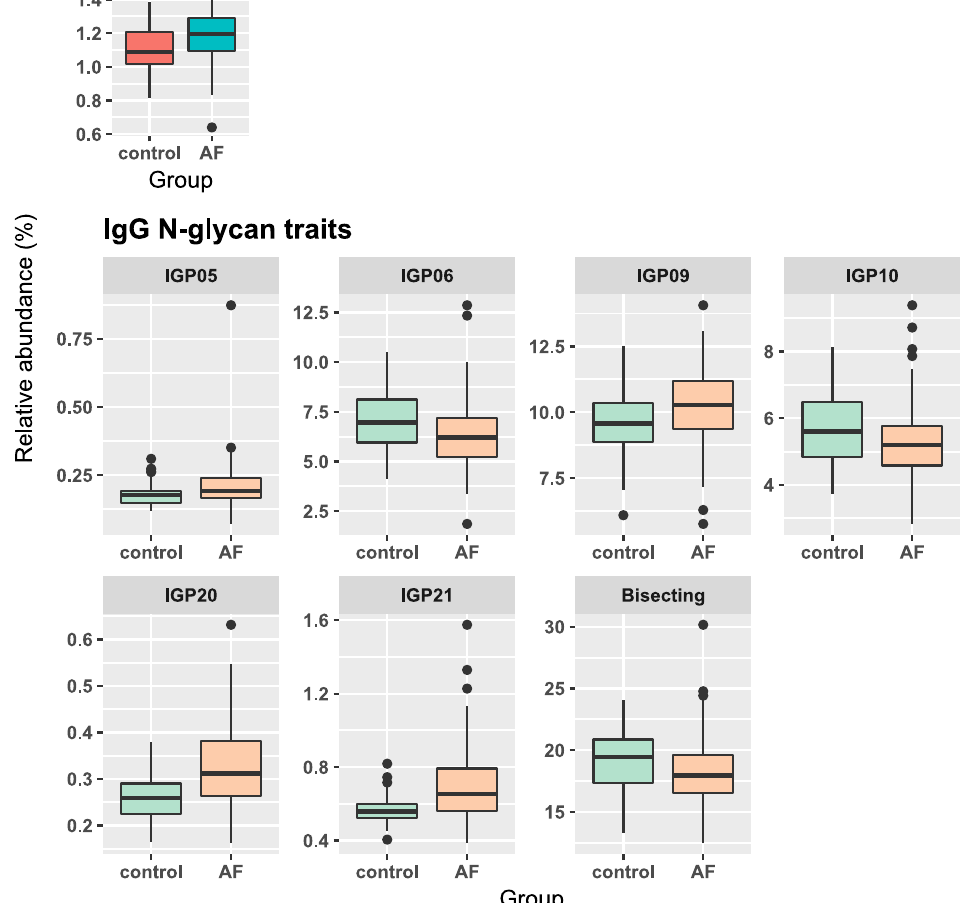
Figure 1. Statistically significant differences in N -glycan traits in plasma and IgG between the control group and AF group. Data are shown as boxplots, the line represents the median value, the box extends from the 25th to the 75th percentile, and the lines extend to the 1.5 × IQR. Outliers outside 1.5 IQR are plotted individually as dots.